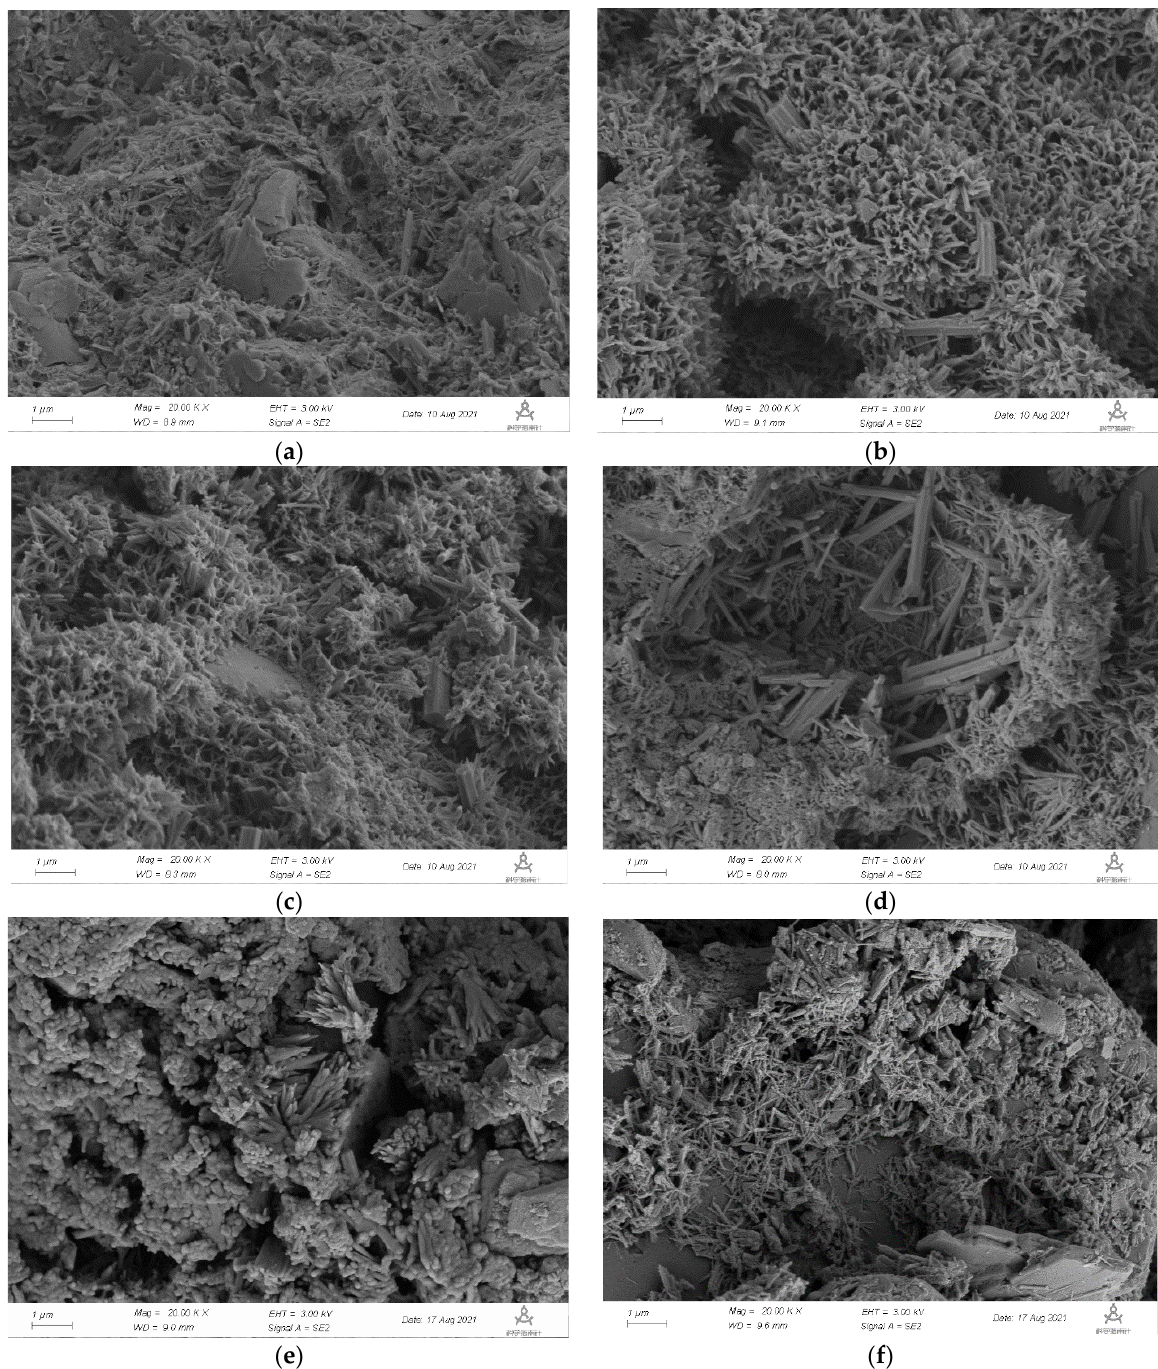
Figure 7. Microstructure of composite cementitious material at 3 days: ( a ) 0% phosphogypsum; ( b ) 10% phosphogypsum; ( c ) 30% phosphogypsum; ( d ) 50% phosphogypsum; ( e ) 70% phosphogyp- sum; ( f ) 90% phosphogypsum.